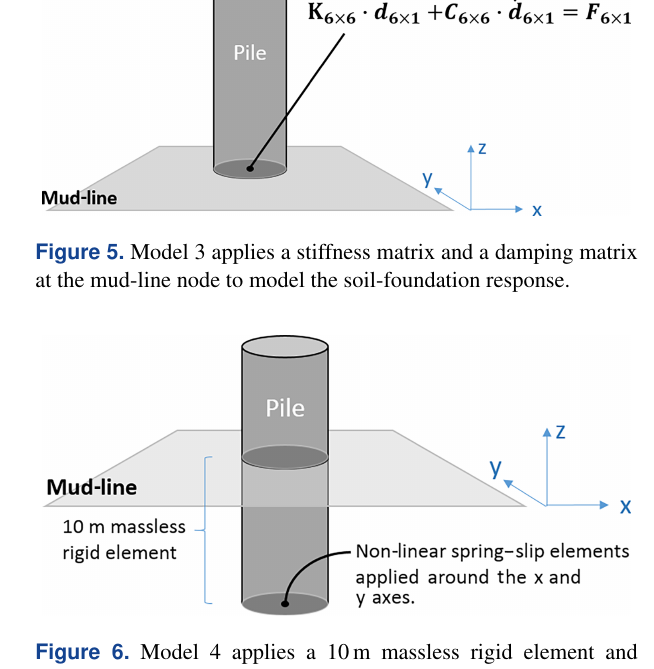
Figure 6. Model 4 applies a 10m massless rigid element and spring–slip elements at the node 10m below the mud-line to model the soil-foundation